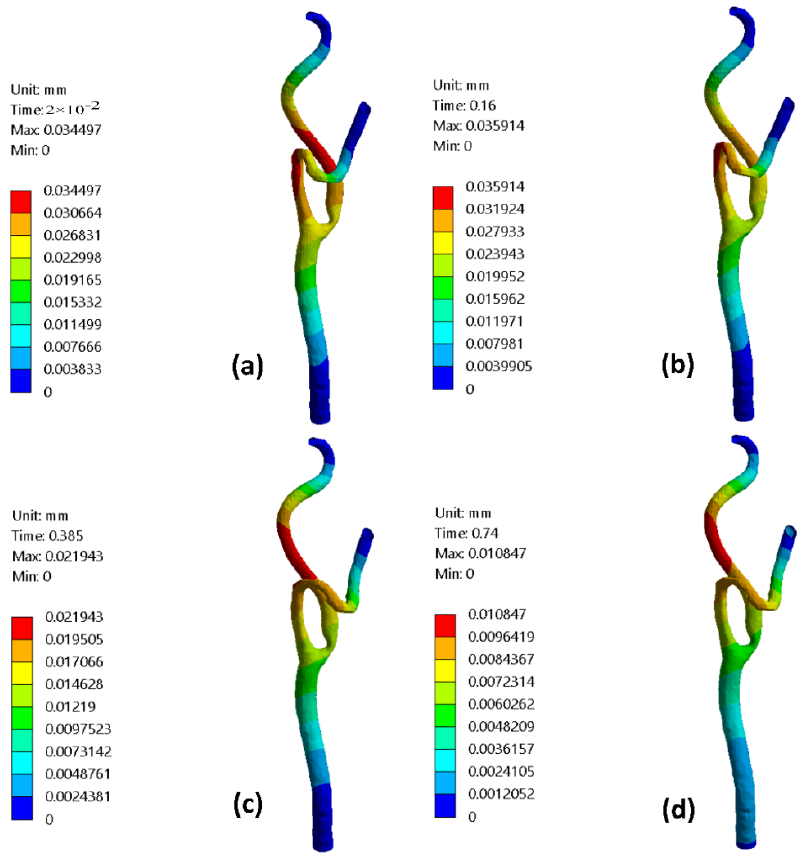
Figure 11. CA—model B deformation contours for different times of the cardiac cycle: ( a ) t = 0.02 s, ( b ) t = 0.16 s, ( c ) t = 0.385 s, and ( d ) t = 0.74 s. For stenotic RCA—model A at the stenotic throat, with pressure = 5406 Pa, diam- eter = 3.77 mm, thickness = 0.55 mm, and the Young modulus of elasticity = 1.08 MPa,